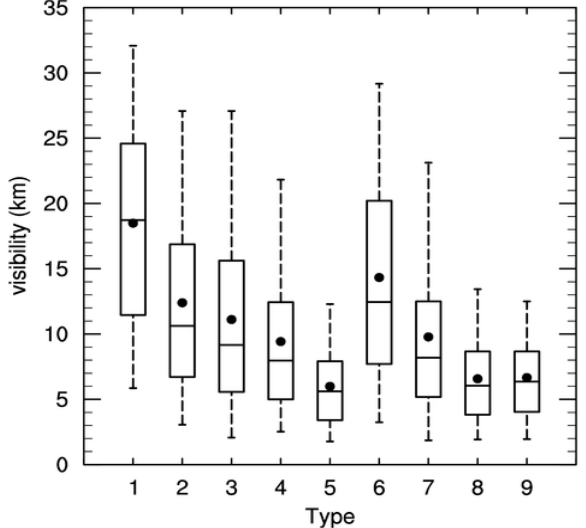
Fig. 6. Daily mean visibility at Beijing airport within the nine clusters. The solid dot denotes the mean. The horizontal lines across the box are the averages of the median, first, and third quartiles, respectively, while the lower and upper crosses represent the means of the 5th and 95th percentiles, respectively.